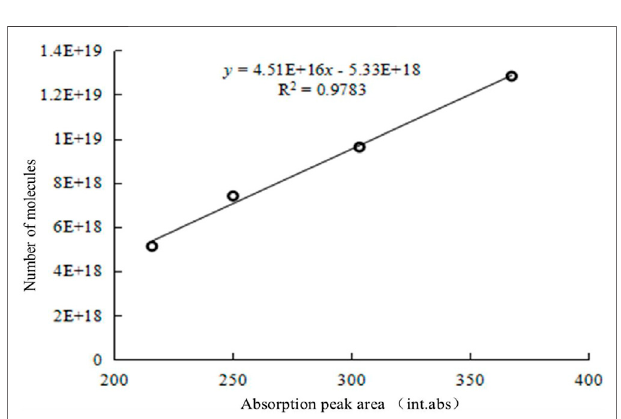
FIGURE 9 | Standard curve of number of DHOPA molecules vs. absorption peak area at 1,640 cm − 1 .